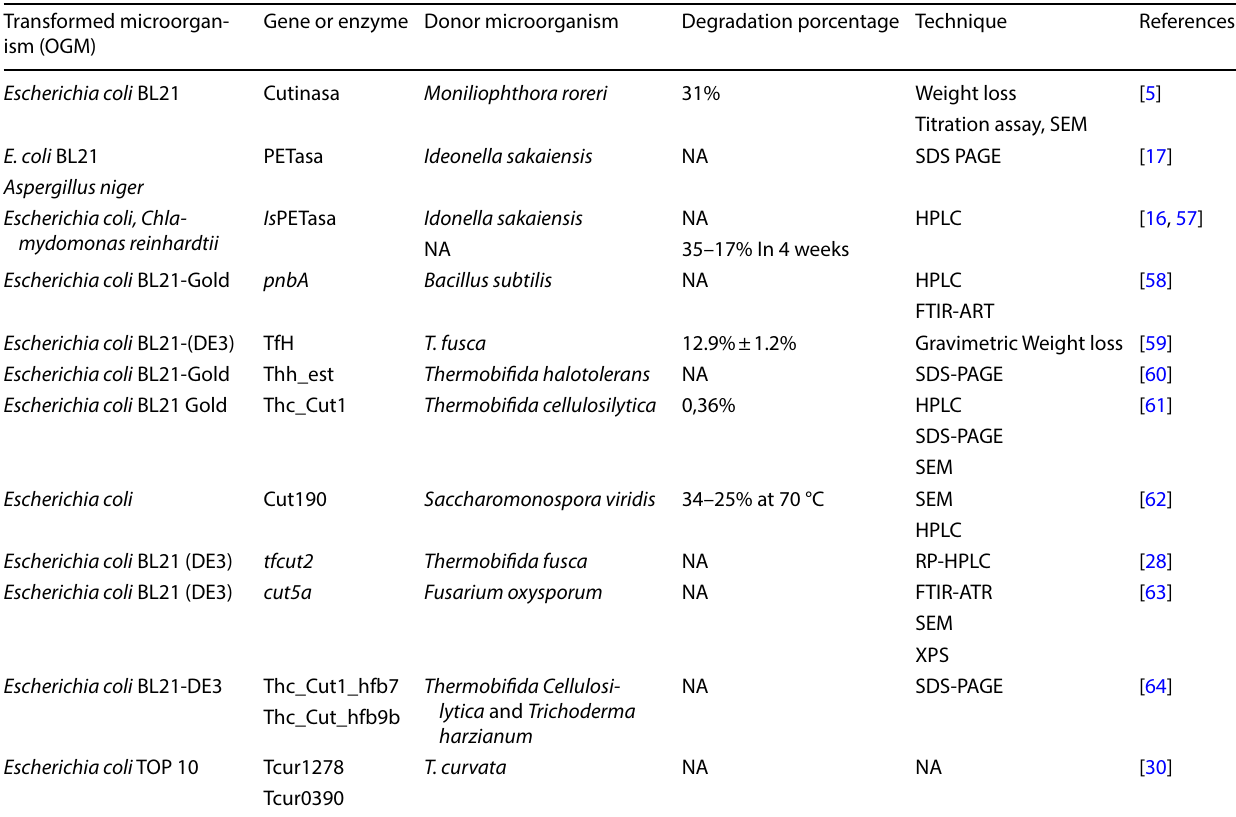
Table 3 Genetically modified microorganisms for degradation of